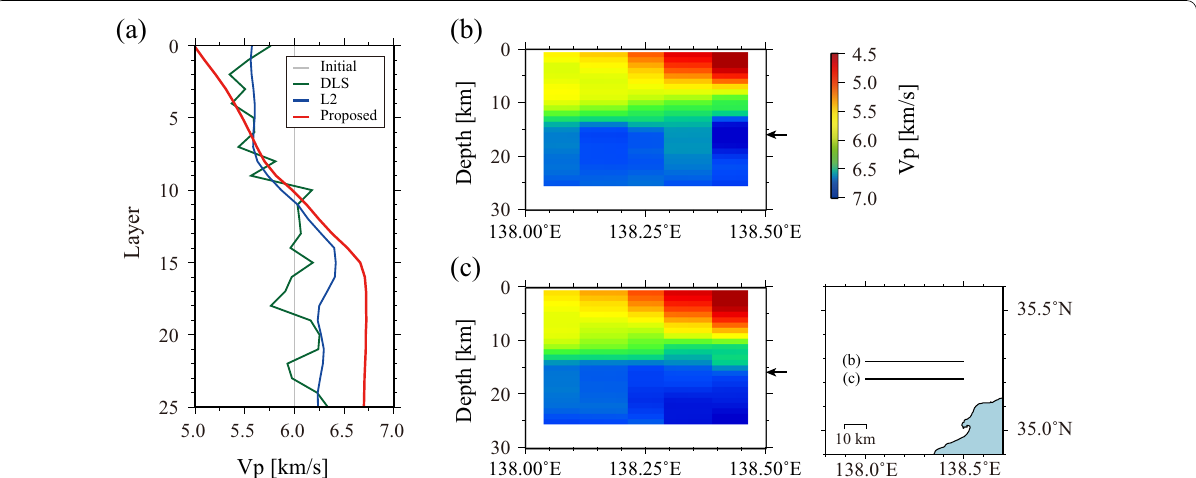
Fig. 10 a Estimated average P-wave velocities. Results of the proposed method, which are derived from real observational data, are shown by the red line. The grey line indicates the initial velocity model. Green and blues lines are the estimated P-wave velocity structures determined via the DLS and l 2 -smoothness regularization (L2) methods, respectively. b , c Vertical and horizontal variations in P-wave velocity. Arrows indicate 16 km depth. Cross-sectional locations are indicated in the inset